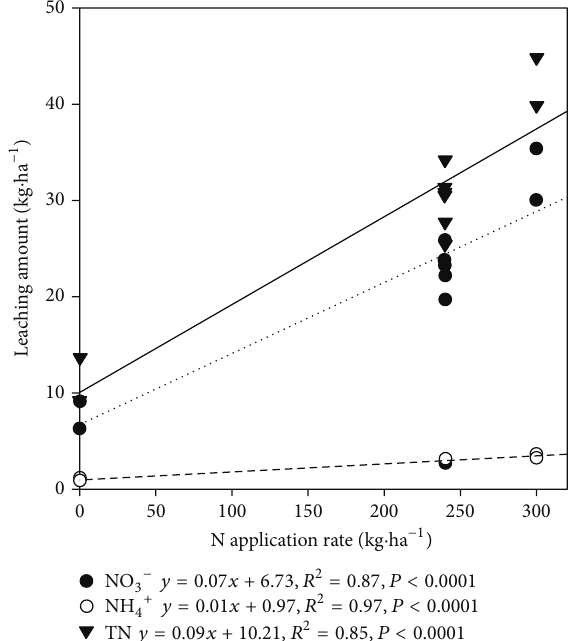
Figure2:LinearregressionrelationshipsbetweenNapplicationrate and leaching amount of TN, NO 3− and NH 4+